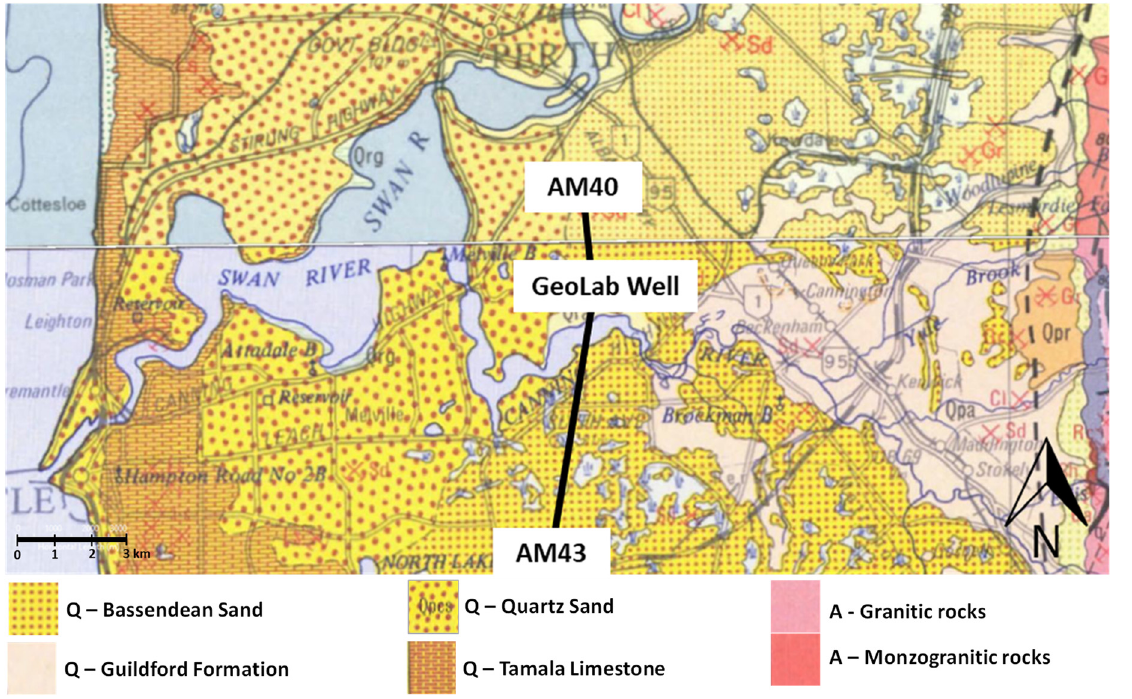
Figure 1. Geological map of the area around GeoLab Well-01 (© State of Western Australia (Depart- ment of Mines, Industry Regulation and Safety, 2020).